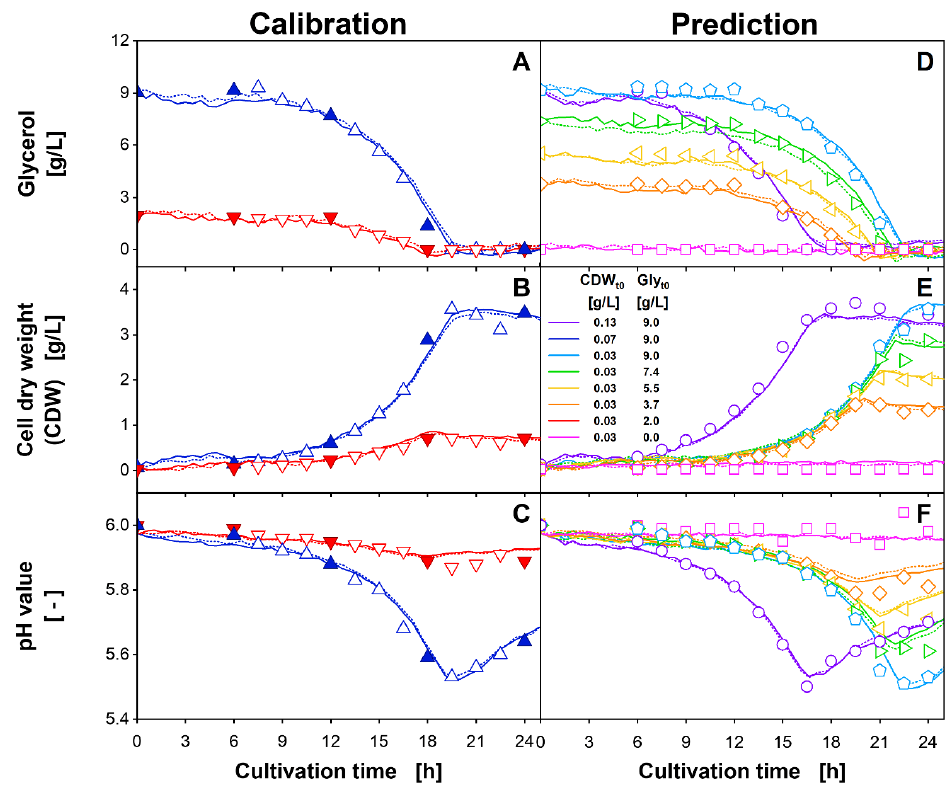
Figure 6. ( A – C ) Calibration and ( D – F ) prediction of the PLS model, generated by including two latent variables and linear interpolation for a 6 h sampling interval for ( A , D ) glycerol, ( B , E ) CDW and ( C , F ) pH value based on 2D spectra of duplicates. For calibration, a total of 212 2D spectra from duplicates of H. polymorpha RB11 pC9- FMD (P FMD -GFP) cultivations for initial biomass (CDW t0 ) and glycerol concentration (Gly t0 ) of 0.07 g/L and 9.0 g/L (blue) as well as of 0.03 g/L and 2.0 g/L (red) were included. The offline values used for linear interpolation and subsequent PLS model calibration are shown as filled symbols. The hollow symbols were used for model validation only. Solid and dotted lines describe the calculated parameter progression of duplicates. Cultivation conditions: 48-well microtiter plate with round geometry, liquid volume = 800 µL, shaking diameter = 3 mm, shaking frequency = 1000 rpm, temperature = 30 °C.